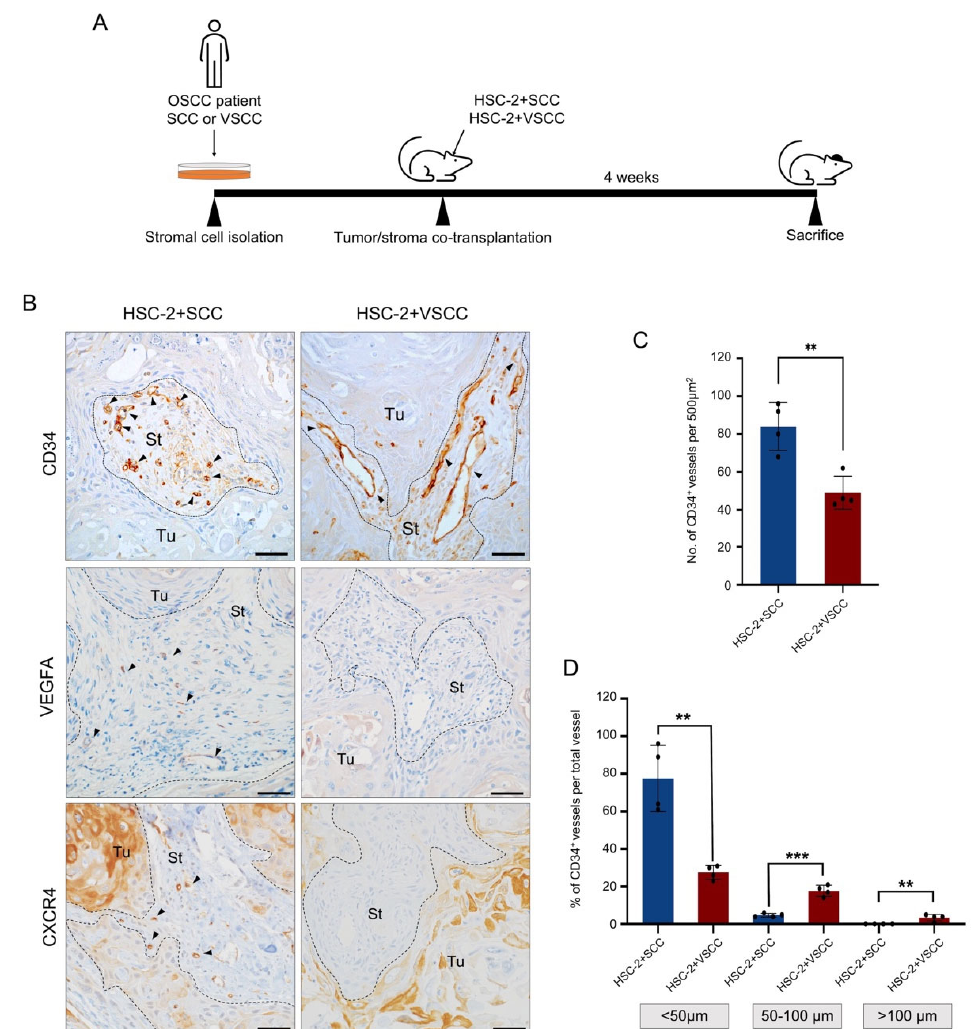
Figure 1. Tumor stroma affects tumor vascularization. ( A ) Illustration of different stroma incorporated oral cancer models establishment. Stromal cells from an oral cancer patient (SCC or VSCC) are isolated. The isolated stromal cells and oral cancer cells (HSC ‐ 2) are co ‐ transplanted subcutaneously at the head of the nude mice. After 4 weeks, the mice are sacrificed. ( B ) Representative images of CD34, VEGFA, and CXCR4 IHC staining. Arrows indicate CD34 + vessels. Dotted lines represent the boundary of the tumor (Tu) and stroma (St) area. Scale bars: 50 μ m. ( C ) The number of CD34 + vessels per 500 µ m 2 area. ( D ) The rate of vessels sized <50 μ m, 50–100 μ m, and >100 µ m. All the data are shown as mean ± SD. Statistical analyses were performed using Student’s t -test; ** p < 0.01, *** p < 0.001.